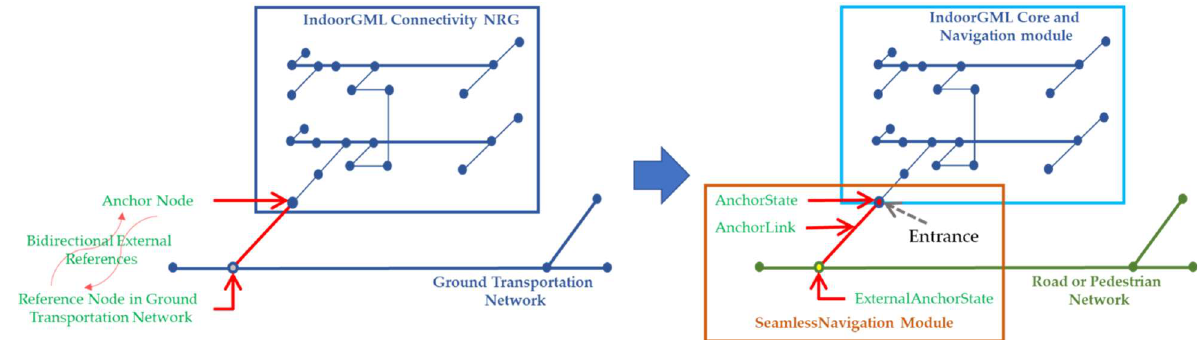
Figure 2. The improved definition of the AnchorNode through the SeamlessNavigation Module [21,42].